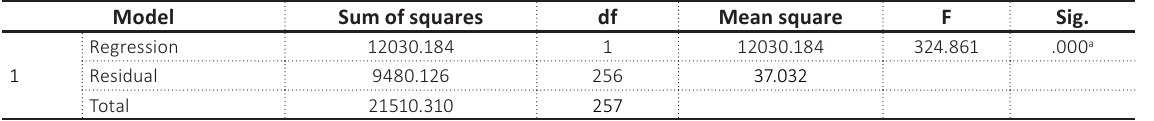
Table 5. ANOVA b